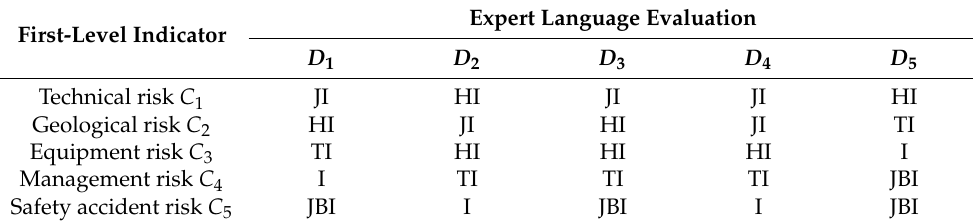
Table 3. Language evaluation of first-level indicators of the expert